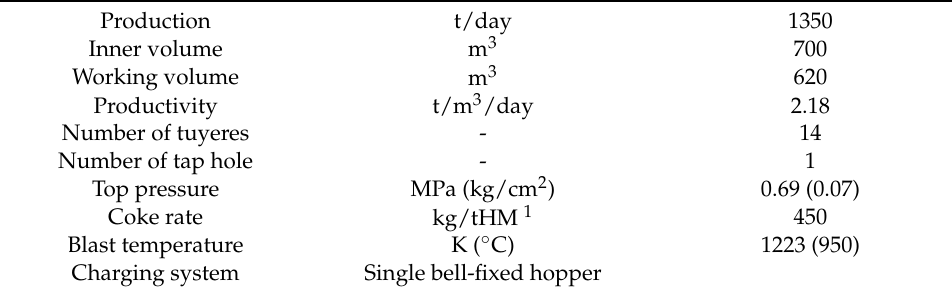
Table 1. BF AFO3 operational features.